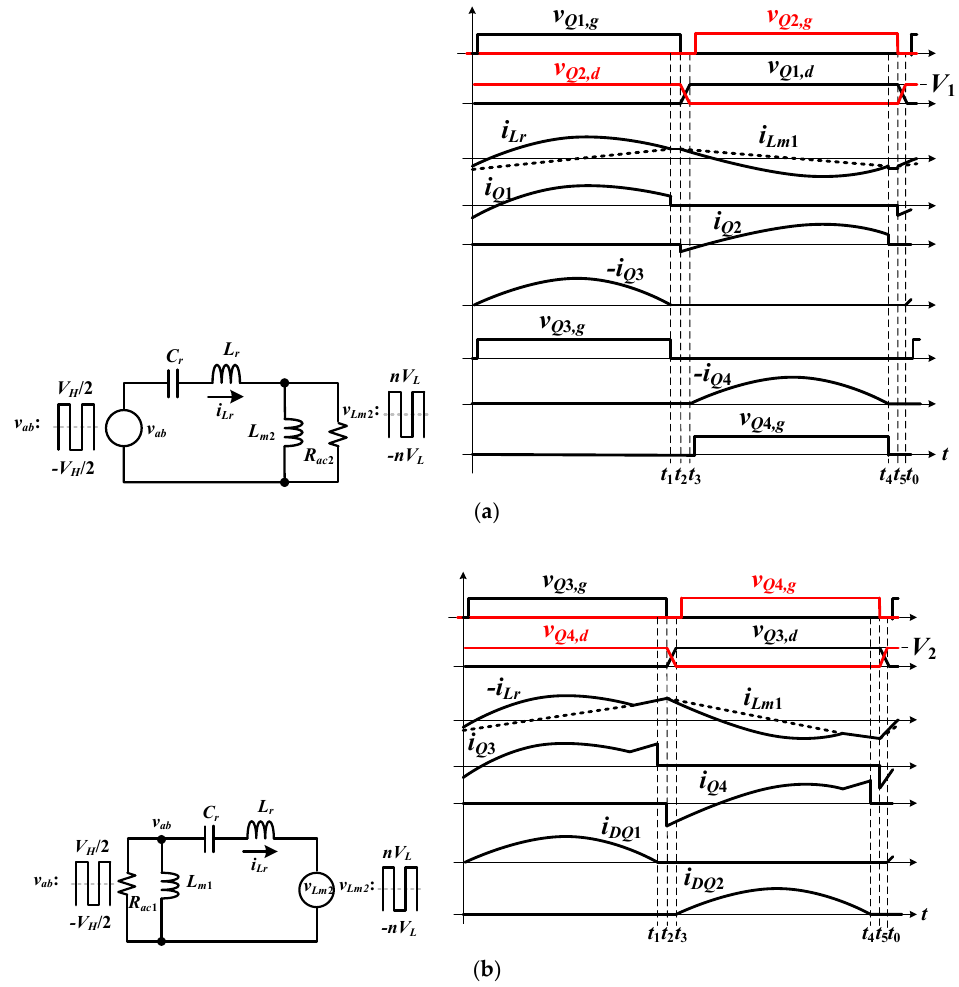
Figure 3. Resonant tank of the studied circuit ( a ) forward power transfer from V H to V L ( b ) backward power transfer from V L to V H .